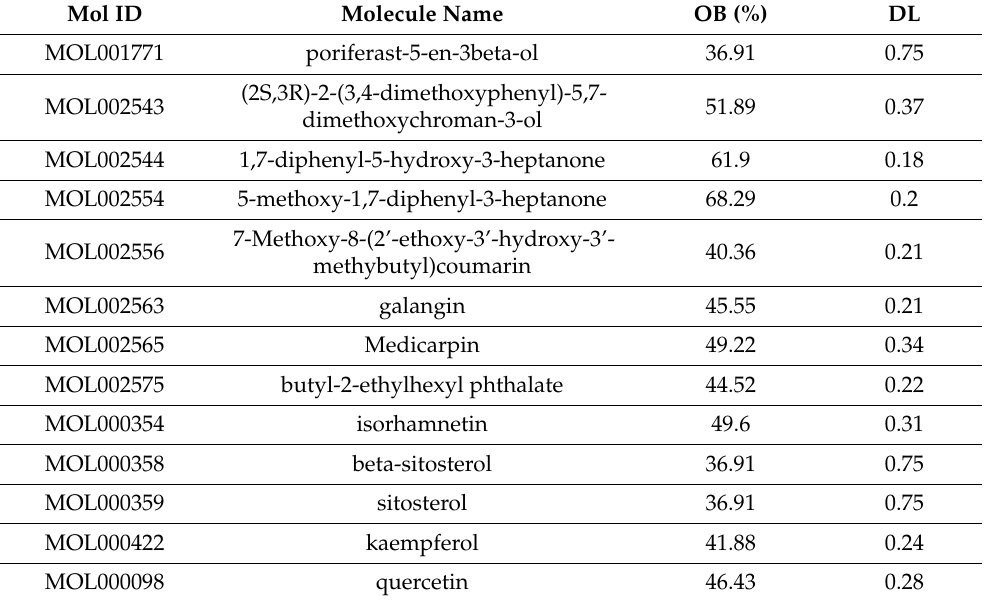
Table 1. Information of 13 effective compounds in Galangal.